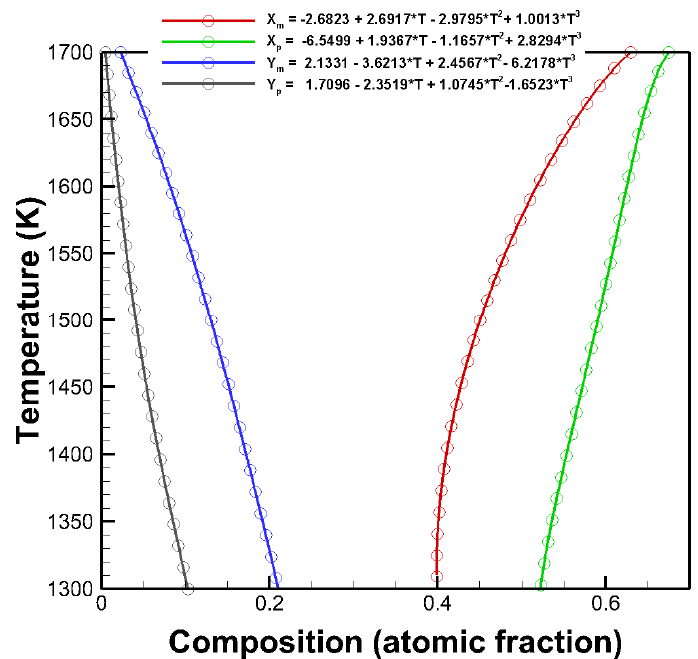
Figure 1. Equilibrium Fe and Nb concentration in the liquid and solid phases in the model Ni–Fe–Nb alloy as a function of temperature. X m and X p are the concentrations of Fe in liquid and solid respectively, and Y m and Y p are the corresponding values for Nb.